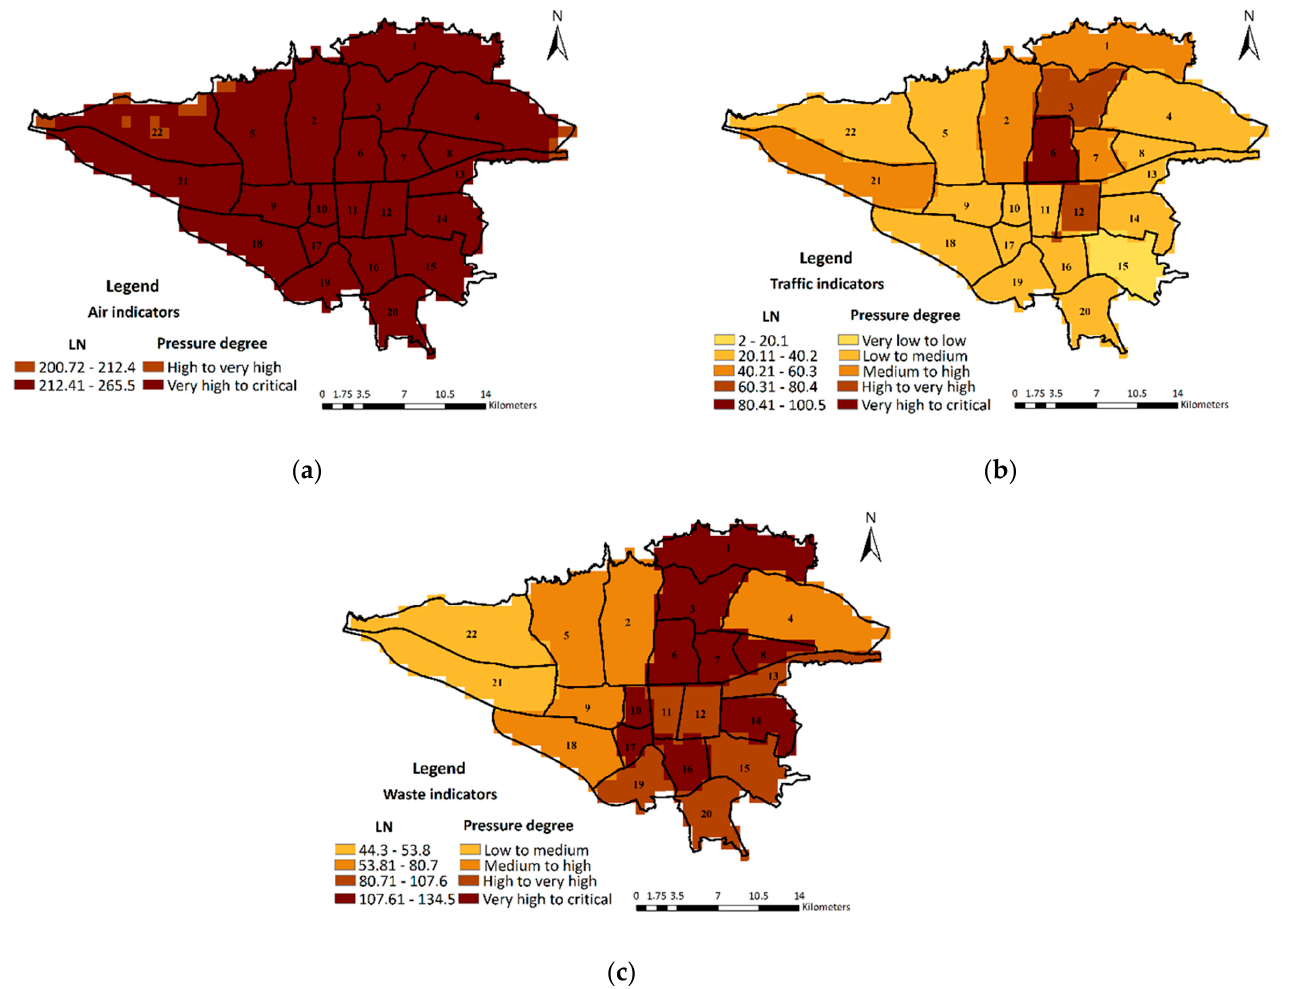
Figure 7. The LN maps of impact components. ( a ) Air; ( b ) tra ffi c; ( c ) waste.